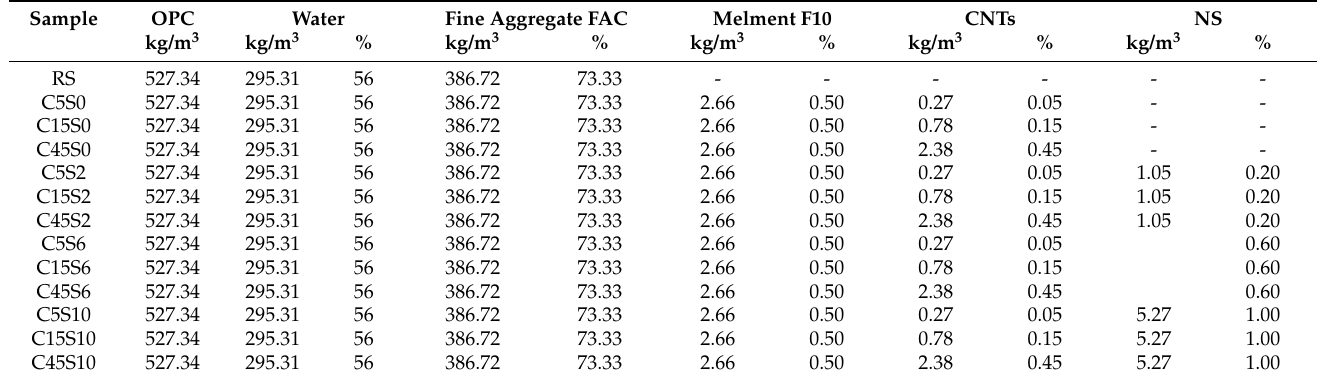
Table 3. Mix Design for the preparation of per cubic meter